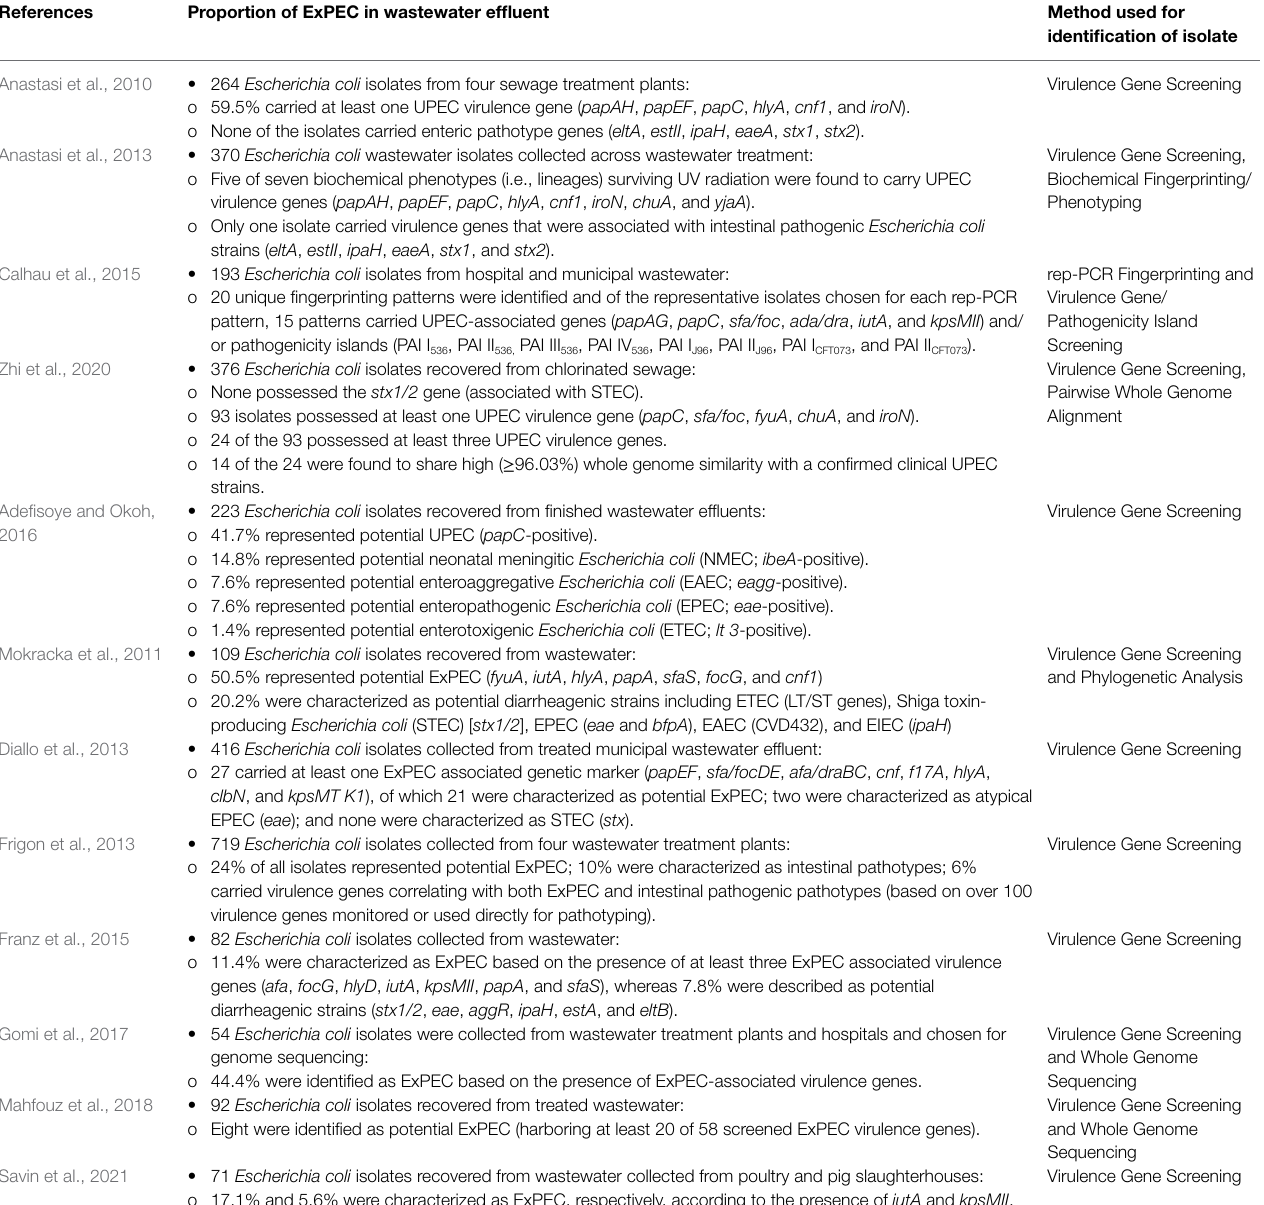
TABLE 2 | Summary of studies evaluating the prevalence of extraintestinal pathogenic Escherichia coli (ExPEC) in treated